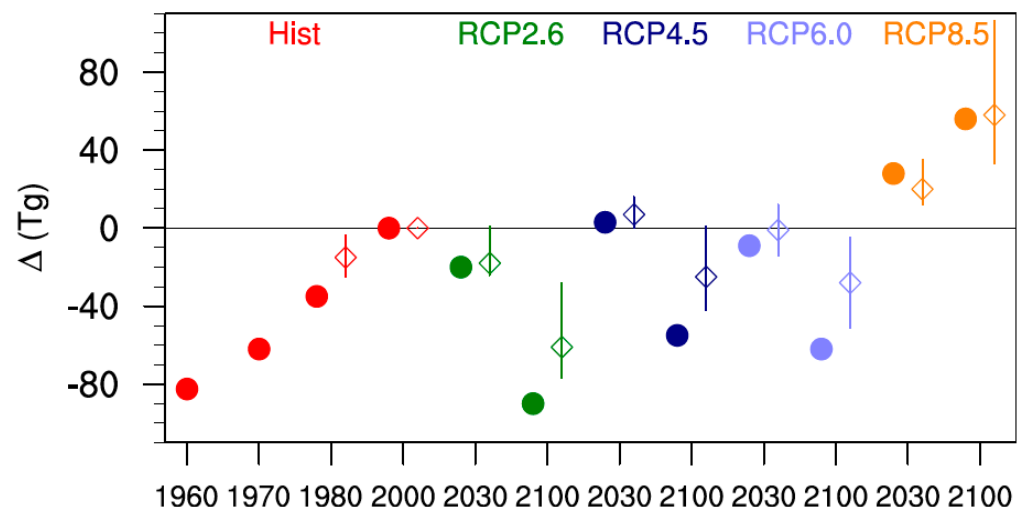
Figure 2. Change in the tropospheric ozone burden (Tg) for the different scenarios, relative to year 2000 values. The filled circles show SOCOLv3 results, while the open diamonds show the ACCMIP (Atmospheric Chemistry and Climate Model Intercomparison Project) multi model mean. The minimum-maximum range for ACCMIP is indicated by the vertical lines. For clarity the data points showing SOCOL and ACCMIP data have been slightly offset with respect to the time axis.